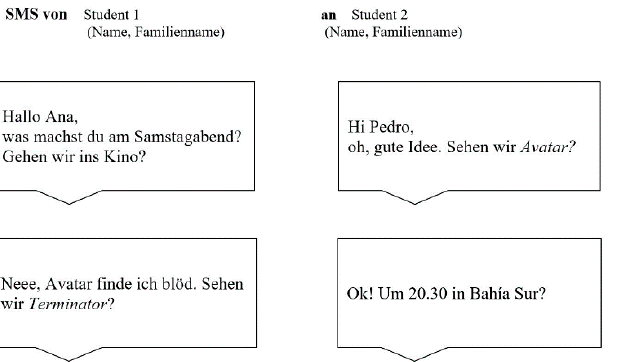
Figure 6. Example of a chat-conversation between two students using the paper version.